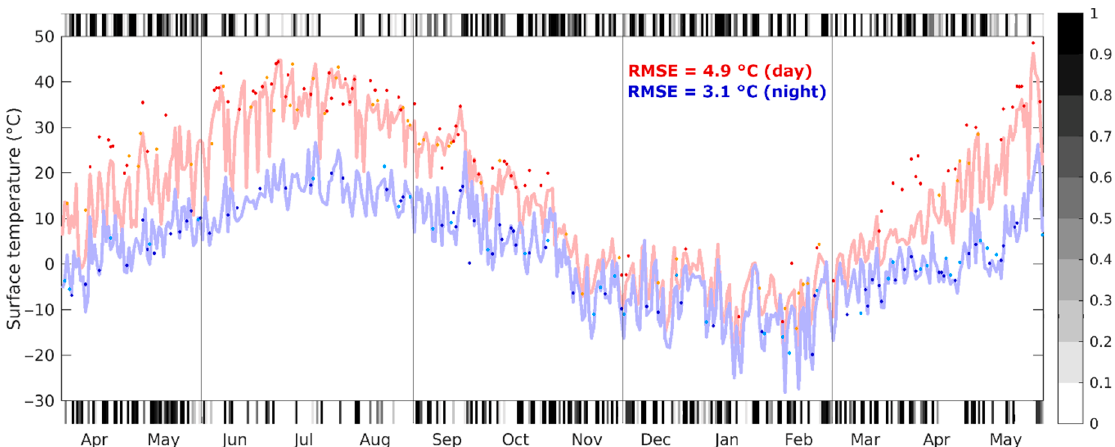
Figure 2. Daily evolution of surface temperature over predominantly urban grid cells in GEM (solid lines), compared to MODIS estimates (coloured dots), for the April 2019–May 2020 period. Daytime temperatures (GEM: 1 p.m.) are shown in red and nighttime temperatures (GEM: 2 a.m.) in blue. Gray shading on top (bottom) denotes the cloud fraction in GEM at 1 p.m. (2 a.m.). For the MODIS data, darker colors denote that at least two thirds of the urban region has valid data, while lighter colors are used when between one third and two thirds of the urban region has valid data.